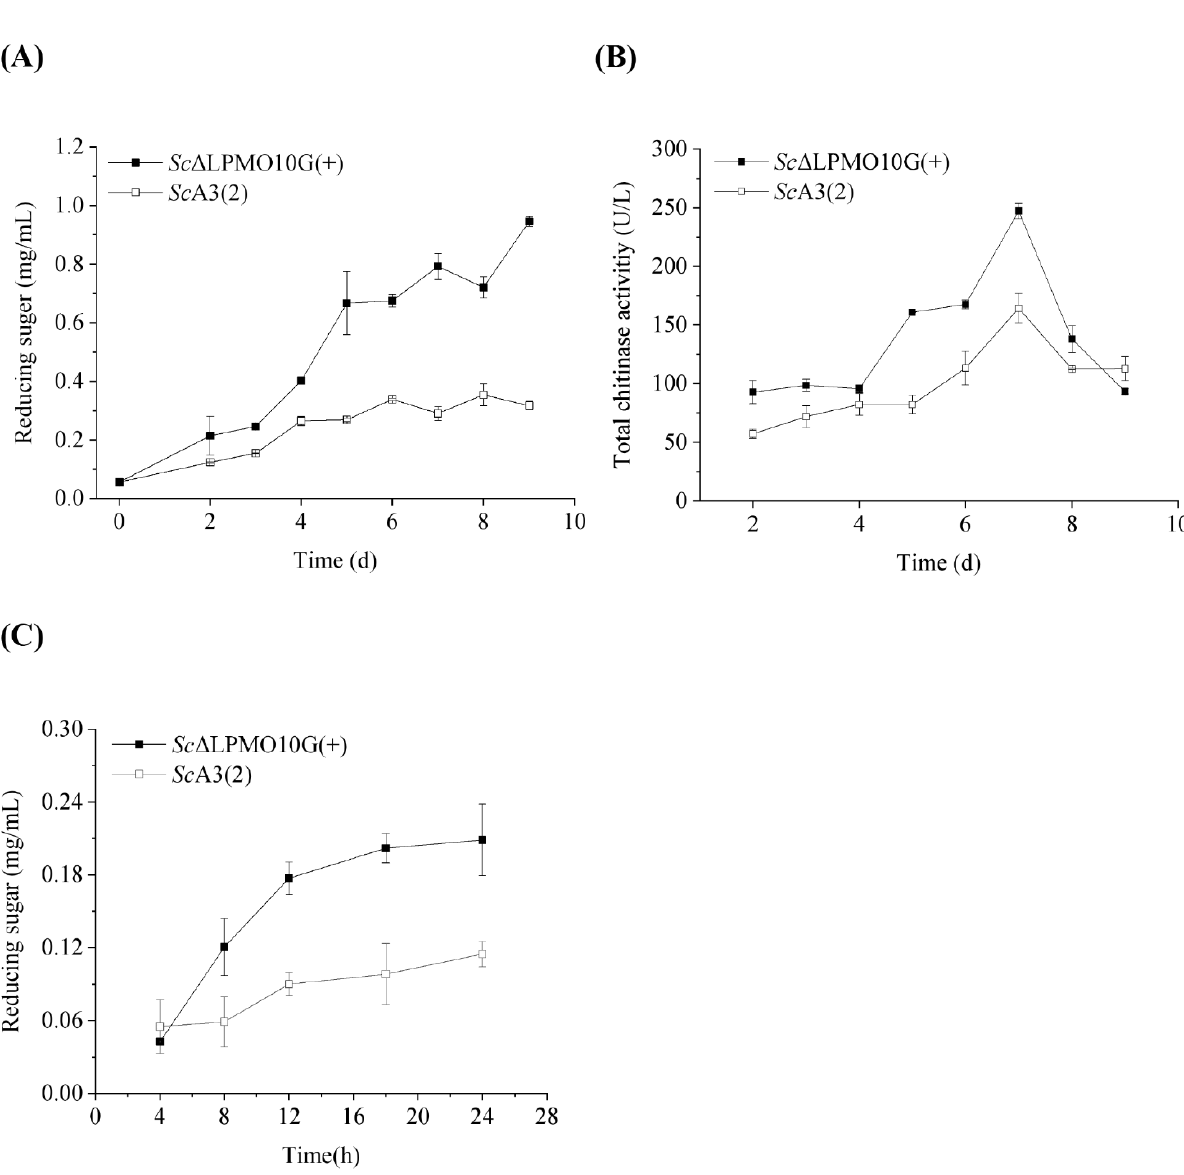
Figure 4. Chitin degradation by wild-type and the Sc ∆ LPMO10G(+) mutant strains. ( A ) The reducing sugar concentration of the culture supernatant during the incubation of wild-type Streptomyces coelicolor A3(2) ( Sc A3(2)) and its mutant strain Sc ∆ LPMO10G(+). The strains were cultivated on MM medium using chitin as the sole carbon source at 28 ◦ C. ( B ) The total chitinase activity of Sc A3(2) and its mutant strain Sc ∆ LPMO10G(+). ( C ) Chitin degradation by extracellular enzyme produced by the wild type Sc A3(2) and its mutant strain Sc ∆ LPMO10G(+). All experiments were performed in triplicate and standard deviation was analysed (SD, n = 3).